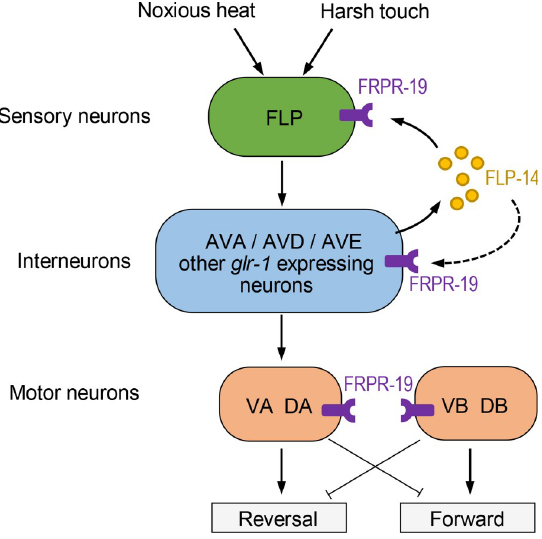
Fig 6. Proposed model for the FLP-14/FRPR-19 signaling modulatory action in the circuit controlling reversal behavior. Schematic of the reversal circuit downstream of FLP sensory neurons showing the expression of FRPR-19 and the potential source of FLP-14 peptides. A positive feedback via an excitatory FLP-14/FRPR-19 peptide signaling could contribute to the maintenance of a high responsiveness under a regime of repeated noxious stimuli. Presumably, a stimulus-dependent activation of the FLP-14/FRPR-19 positive feedback loop may counteract antagonistic habituation mechanisms. The place of action of these pro-habituation mechanisms is unknown. Additional FLP-14 sources are not ruled out by our data (not